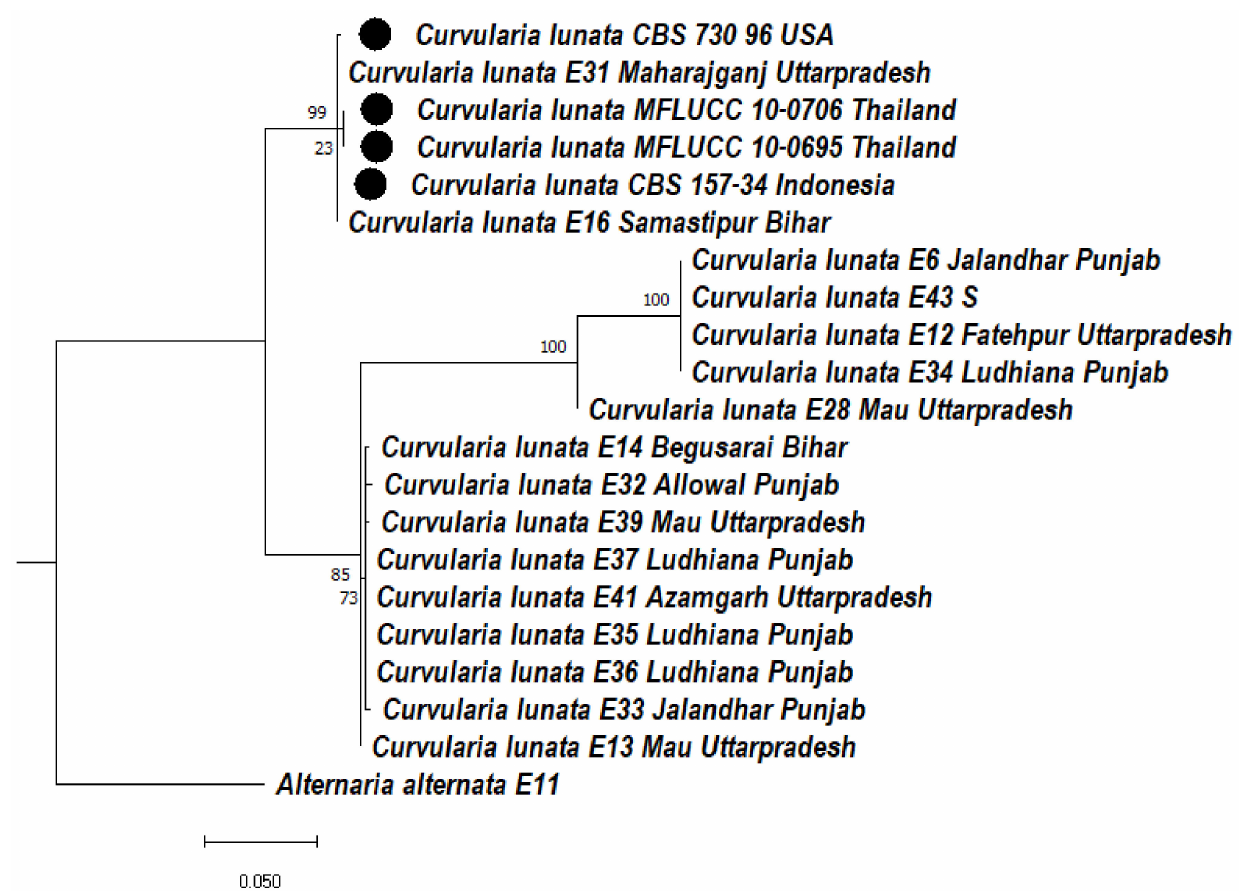
Figure 5. Dendrogram constructed from maximum likelihood method based on combined internal transcribed spacer (ITS), and large subunit gene regions (LSU) and glyceraldehyde-3-phosphate dehydrogenase (GAPDH). Sequenced data of the Curvularia lunata isolates were inferred with Raxml based on GTR + Gamma model. Numerical value presented in the node indicates bootstrap value with a 1000 non-parametric bootstrap replicate analysis. The symbol • denotes as ‘ ex-type ’ closely related species sequences obtained from GenBank. Alternaria alternata used as an